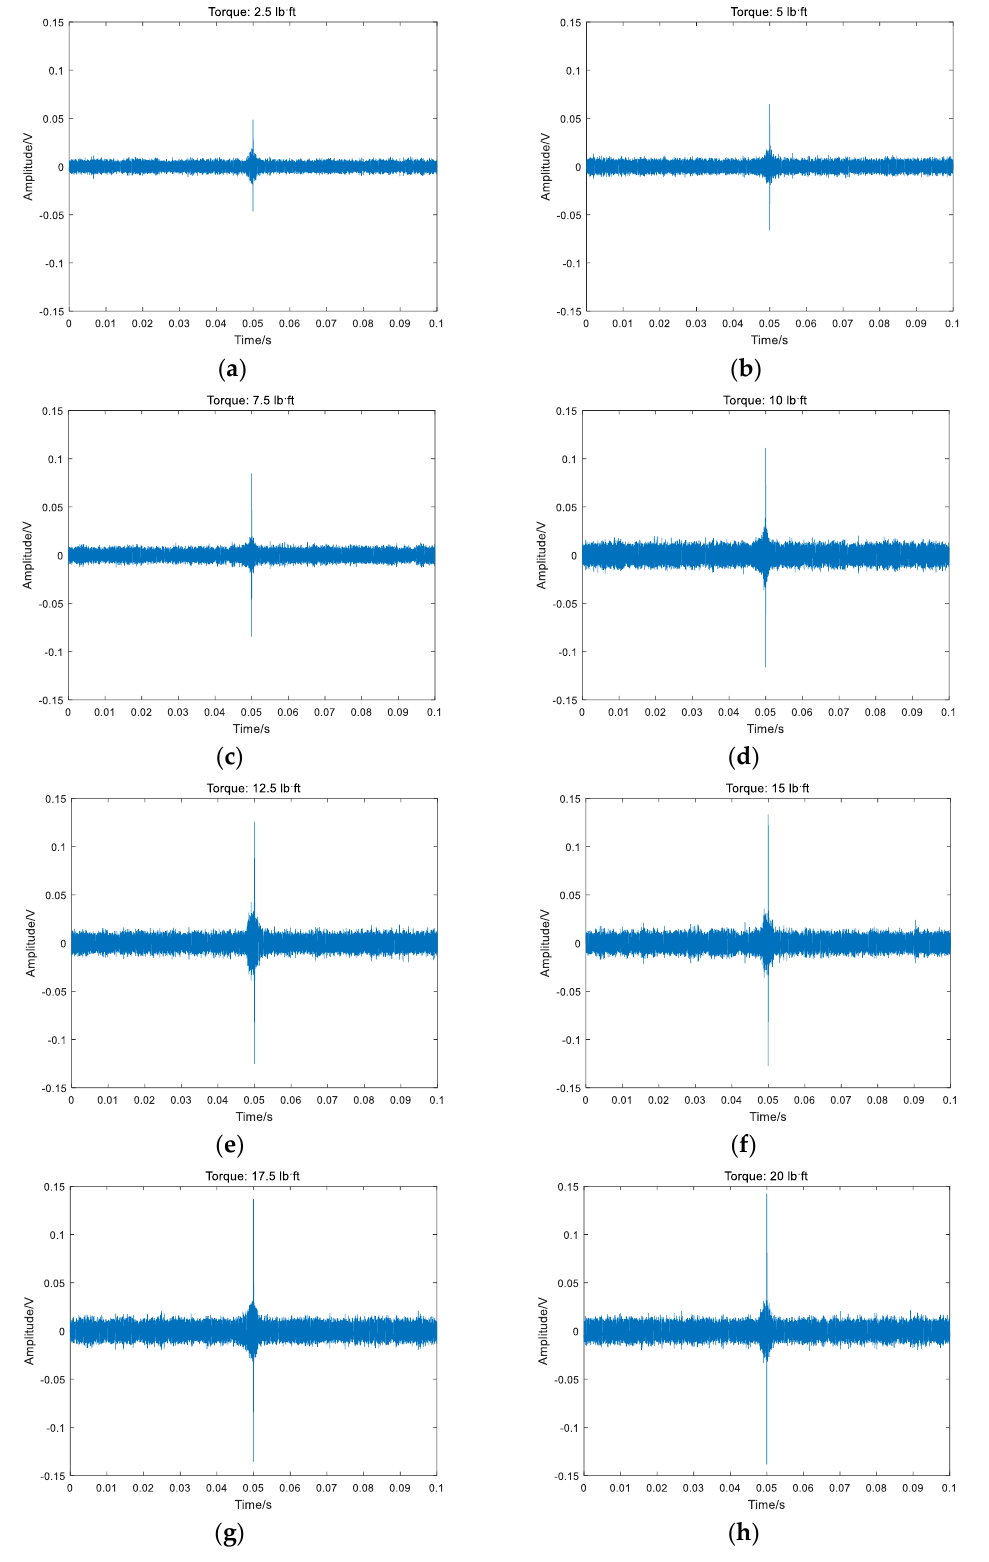
Figure 12. The focused signals based on the time reversal method at different torque levels on bar 5: ( a ) Focused signals at 2.5 lb ⋅ ft torque; ( b ) Focused signals at 5 lb ⋅ ft torque; ( c ) Focused signals at 7.5 lb ⋅ ft torque; ( d ) Focused signals at 10 lb ⋅ ft torque; ( e ) Focused signals at 12.5 lb ⋅ ft torque; ( f ) Focused signals at 15 lb ⋅ ft torque; ( g ) Focused signals at 17.5 lb ⋅ ft torque; ( h ) Focused signals at 20 lb ⋅ ft torque.